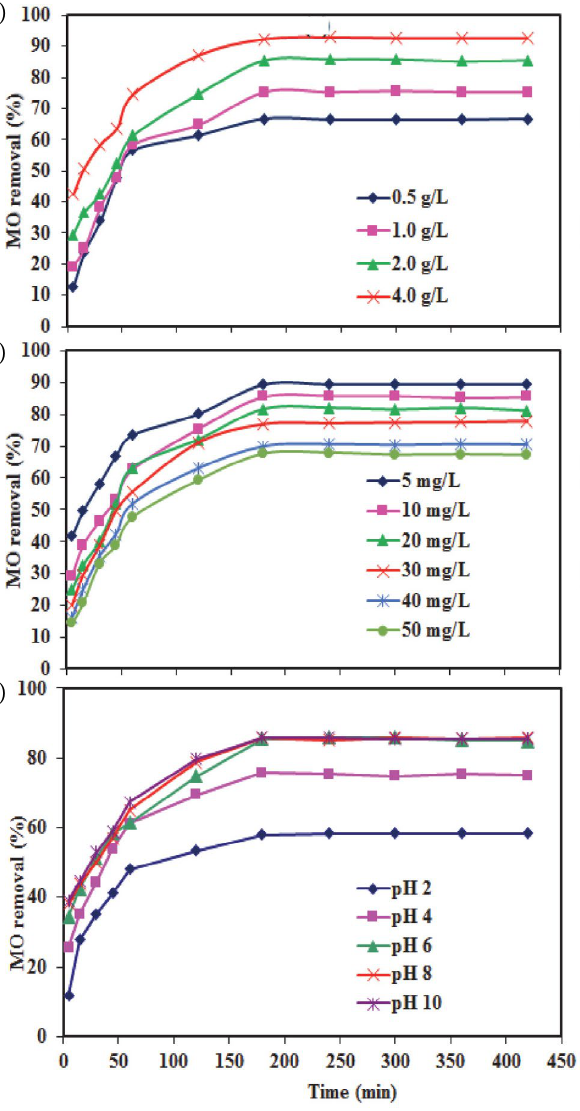
Figure 4. Effects of the different parameters on adsorption of MB and MO: dosages of GCM (a), initial concentrations of dyes (b), and different pH values of aqueous solutions